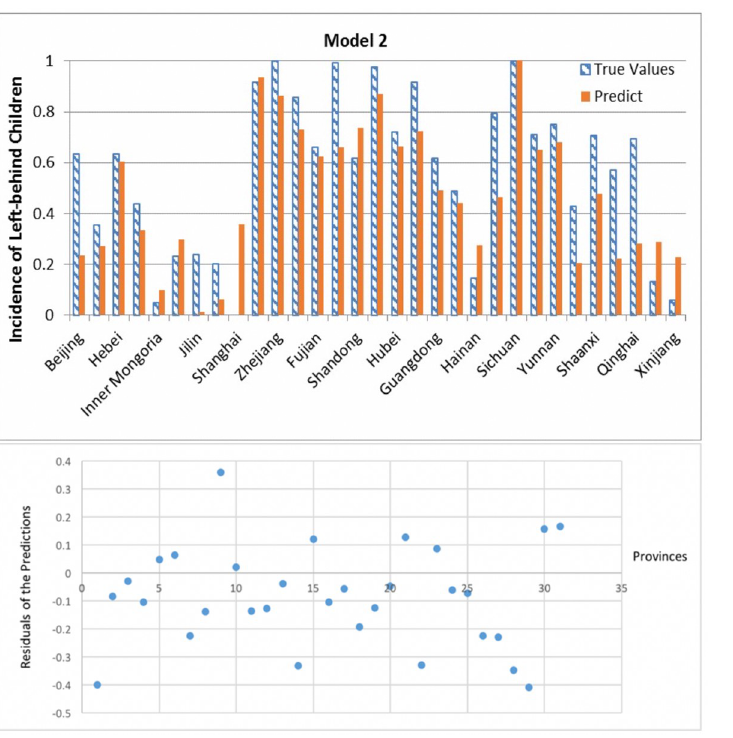
Fig 10. Prediction results and residuals of Model